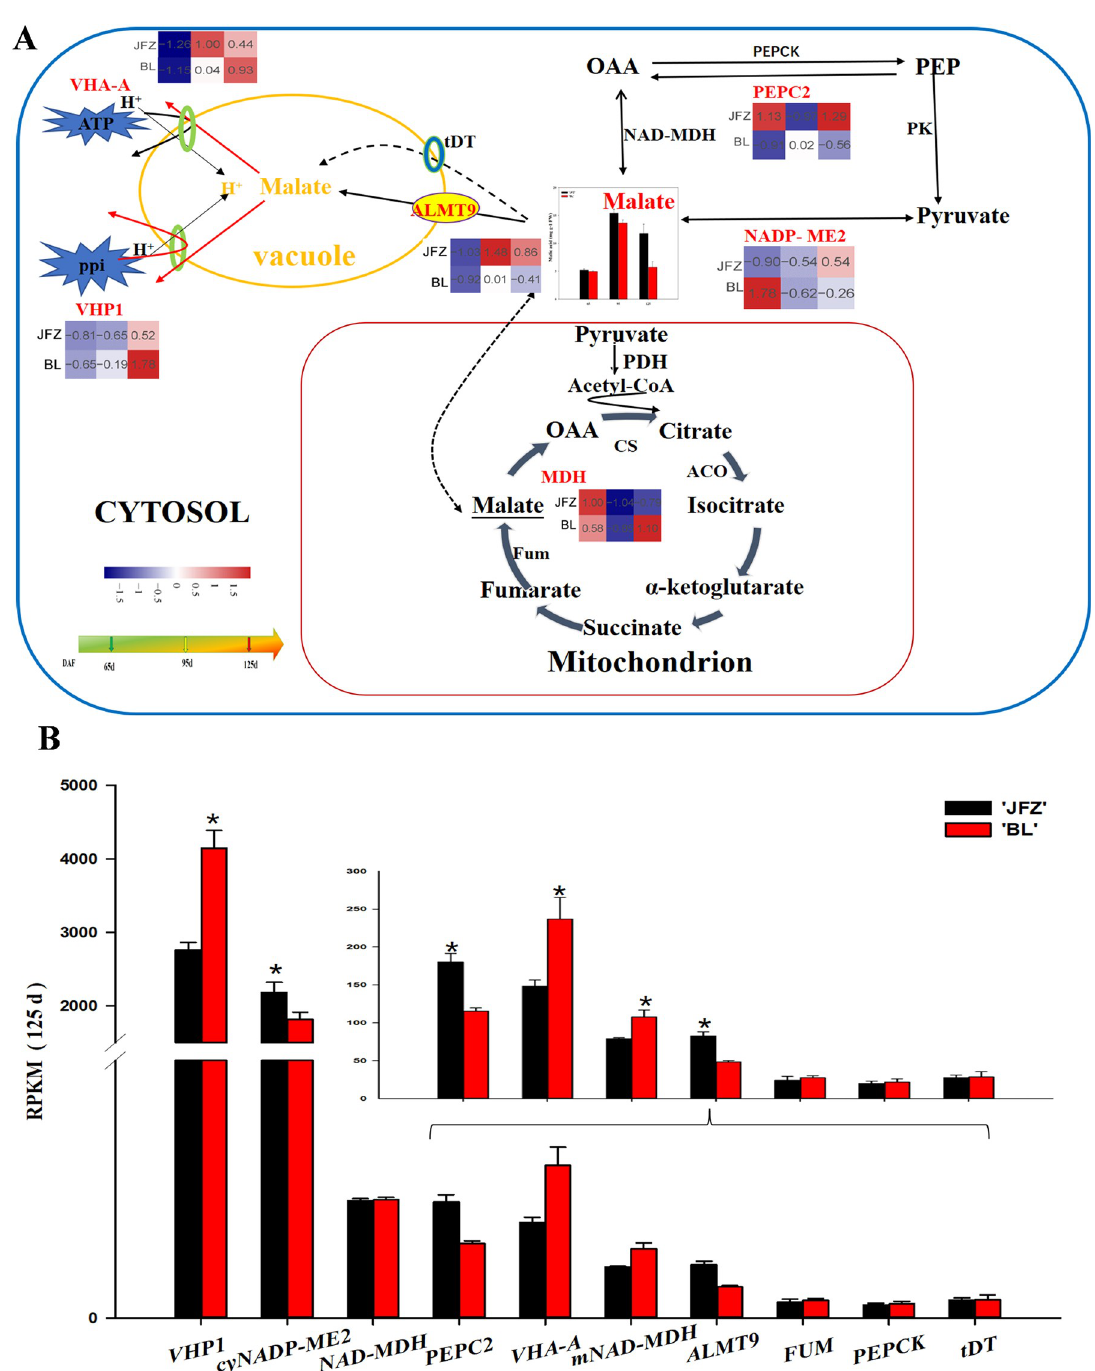
Fig 4. Regulation of main organic acid (malate) metabolism during loquat fruit development. (A) The transcript level trends were determined using log2-transformed values. The malic acid content is shown in columns. The color of the heat map from blue to red represents the gene transcript levels from low to high. (B) Transcript level analysis of genes involved in organic acid metabolism of two loquat cultivars at 125 DAF. Differences among the samples were analyzed by two (cultivars) × three (sampling dates) ANOVA. The asterisks represent P < 0.05. Each point represents the mean ± SD (n = 3). RPKM: reads per kilobase per million.